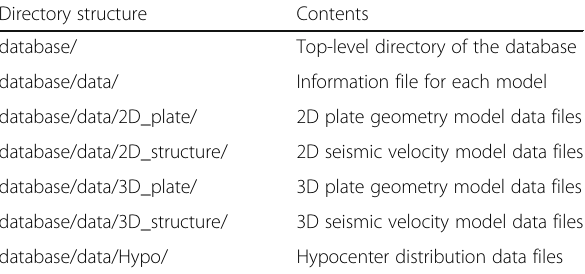
Table 1 Structure of the file system used for data